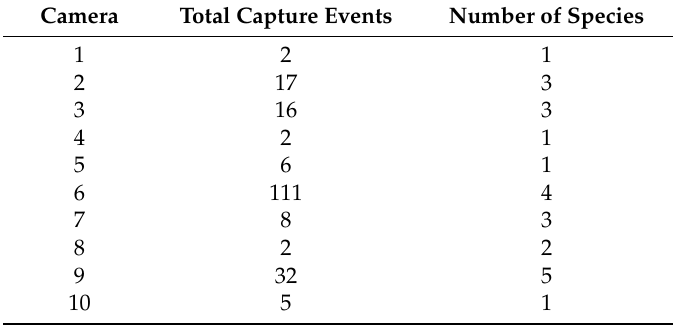
Table 5. Bird capture events and number of species at each camera on the 20 km stretch of studied railway from 2015 to 2016.